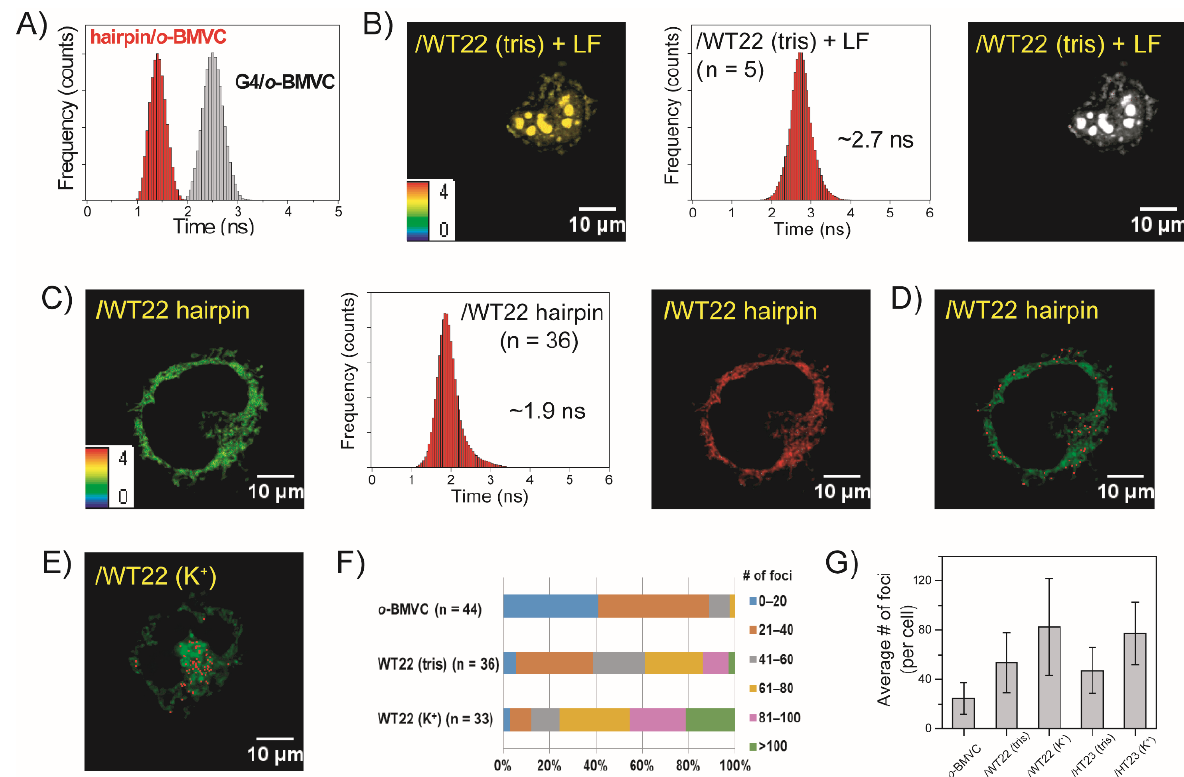
Figure 3. Imaging study of conformational change in exogenous WT22 from a hairpin structure to a G4 structure in live CL1-0 cells. ( A ) The histograms of the fluorescence decay time of o -BMVC upon interaction with WT22 in tris-buffer and in 150 mM K + solution. ( B ) Lipofectamine was used to deliver a mixture of 1 µ M o -BMVC and 3 µ M hairpin WT22 into the nucleus of live CL1-0 cells overnight; the FLIM image ( left ) and histogram of the decay times of o -BMVC fluorescence ( middle ) together with its time-gated image are presented in the pseudocolors of white (decay time ≥ 2.4 ns), which resulted from the interaction with the G4 structures, and red (decay time < 2.4 ns), which represents intereactions with others ( right ). ( C ) FLIM image of a mixture of 5 µ M o -BMVC and 15 µ M hairpin WT22 incubated with live CL1-0 cells (left) and a histogram of the decay times of the o -BMVC fluorescence ( middle ) together with its time-gated image for 2 h ( right ). ( D ) Using the Otsu threshold method to analyze the time-gated FLIM image, the analyzed binary images were separated into two colors: red (decay time ≥ 2.4 ns) and green (decay time < 2.4 ns). ( E ) The analyzed binary images of WT22 G4s incubated with live CL1-0 cells for 2 h. ( F ) Quantitative analysis of the number of o -BMVC foci and ( G ) the average number of o -BMVC foci per cell and its mixtures with hairpin WT22 and WT22 G4 together with ssHT23 and HT23 G4 in live CL1-0 cells.